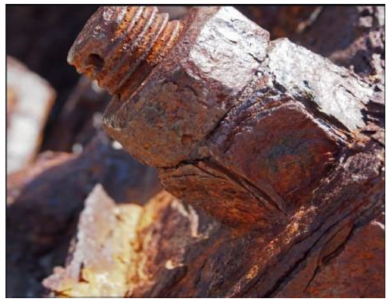
Figure 16. Corrosion product on steel